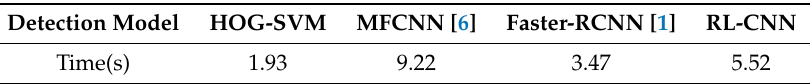
Table 5. Average processing time on each testing